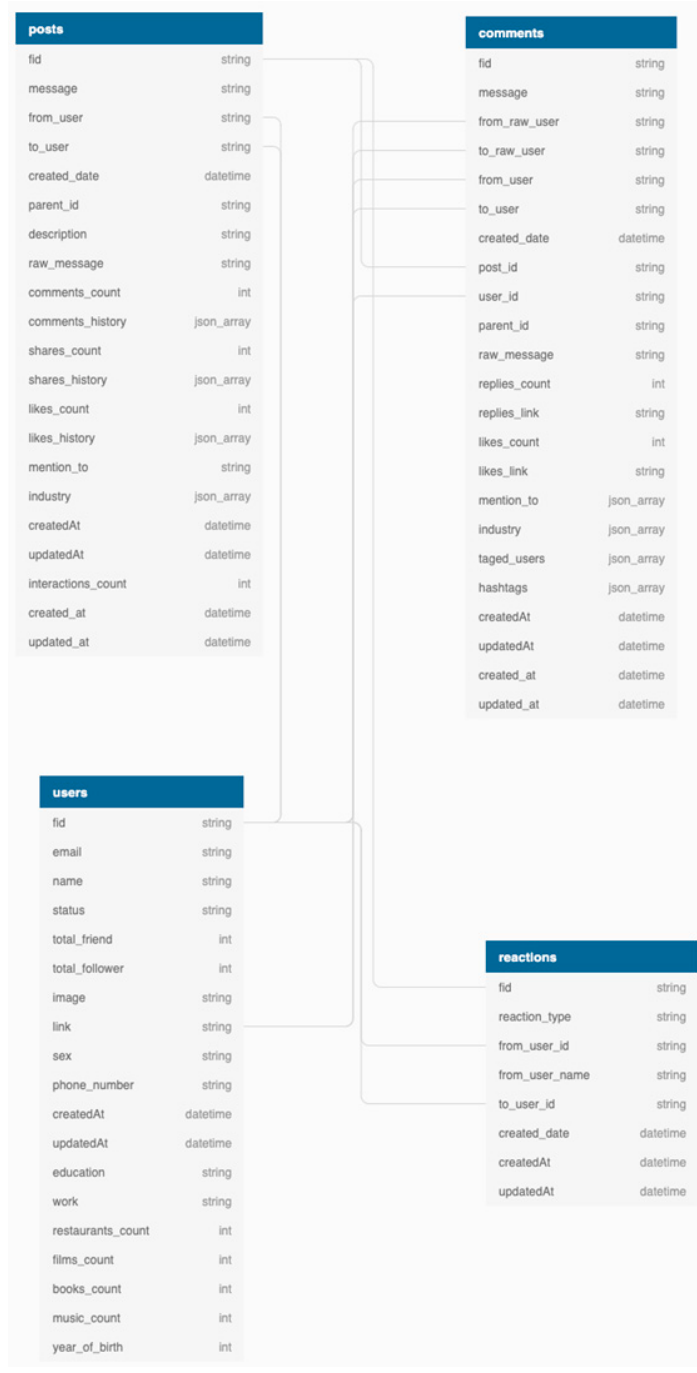
Figure 6. Raw database schema.